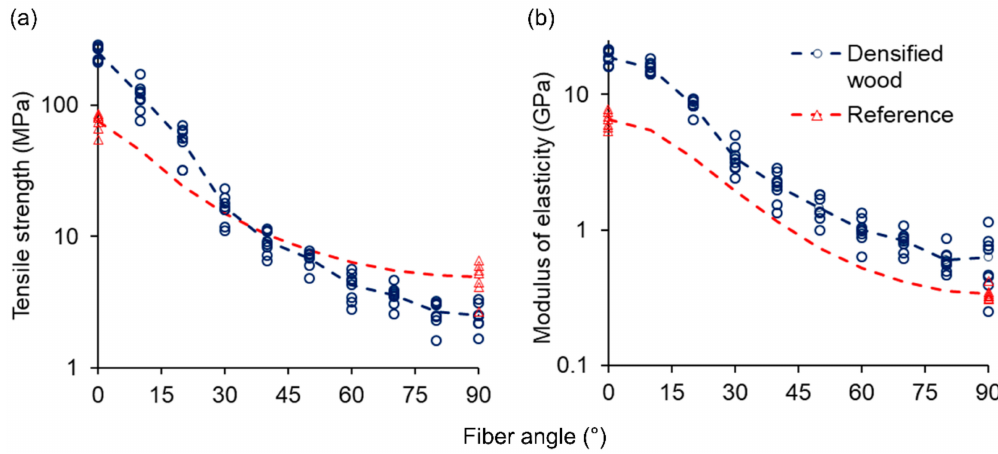
Figure 2. Mechanical characterization of partially delignified and densified wood at di ff erent fiber angles compared to untreated reference wood by tensile tests: ( a ) Strength; ( b ) Modulus of elasticity (log-scaling was chosen for improving the visualization of di ff erences at high fiber angles). (n = 7 for reference samples with a misalignment angle of 0 or 90 ◦ ; n = 7 for alkaline-treated and densified samples with a fiber misalignment angle of 0 or 20 ◦ ; n = 8 for alkaline-treated and densified samples with a fiber misalignment angle of 10 ◦ or 30–90 ◦